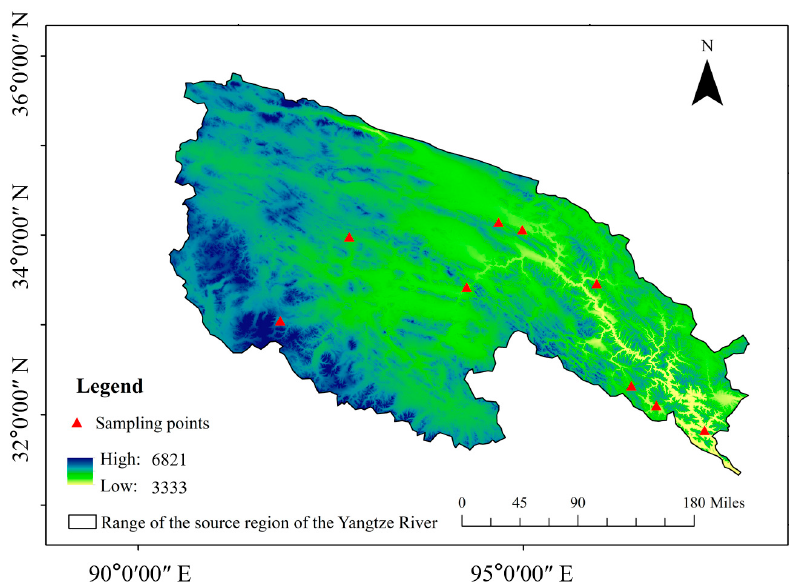
Figure 1. The source region of the Yangtze River. Table 1. Wetlands in the source region of the Yangtze River were chosen for continuous